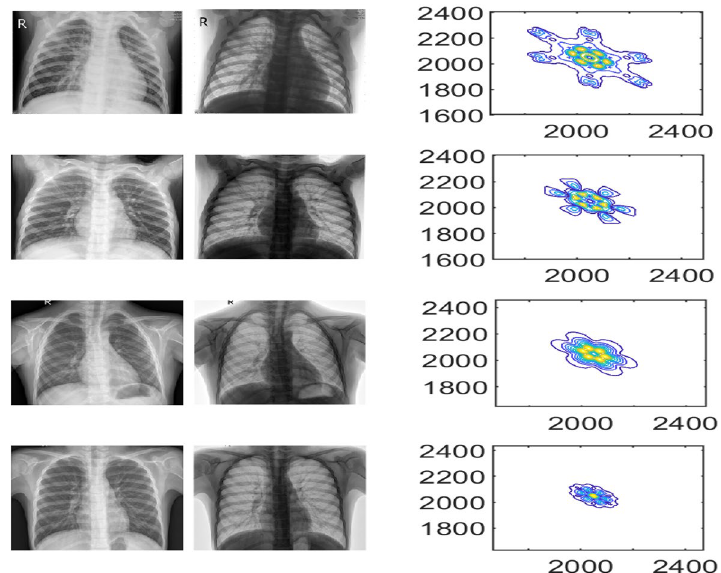
Figure 8. CoViD19+ve (first two rows) and CoViD19−ve (last two